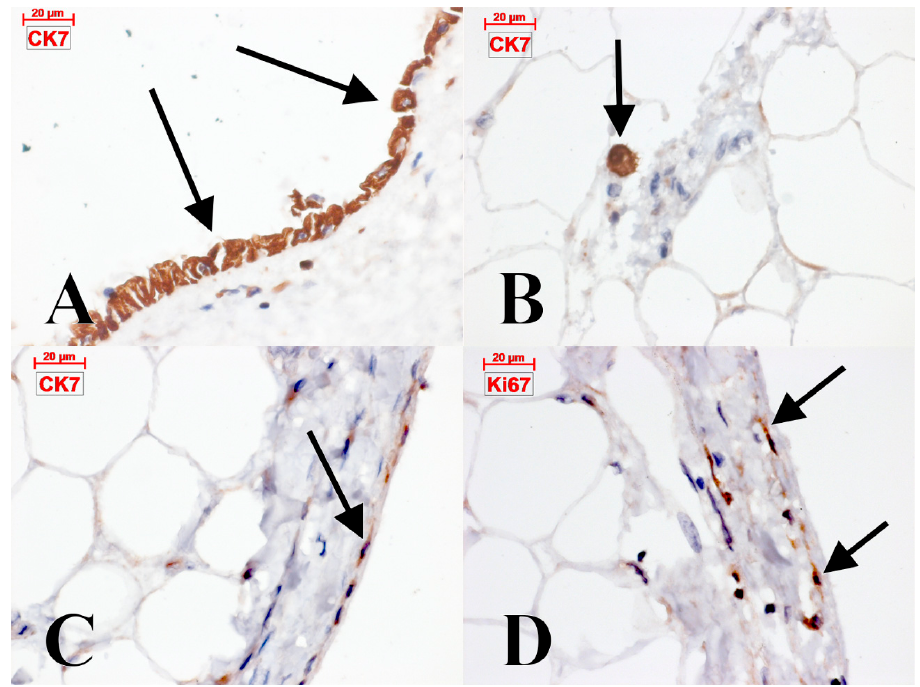
Figure 2. Human adult cardiac wall. Cytokeratin 7 is expressed in epicardial (mesothelial) cells ( A , arrows), as well as in isolated subepicardial round cells ( B , arrow) and in immediate subepicardial spindle-shaped slender cells ( C , arrow). These last also express Ki67 ( D , arrows), the proliferative marker.